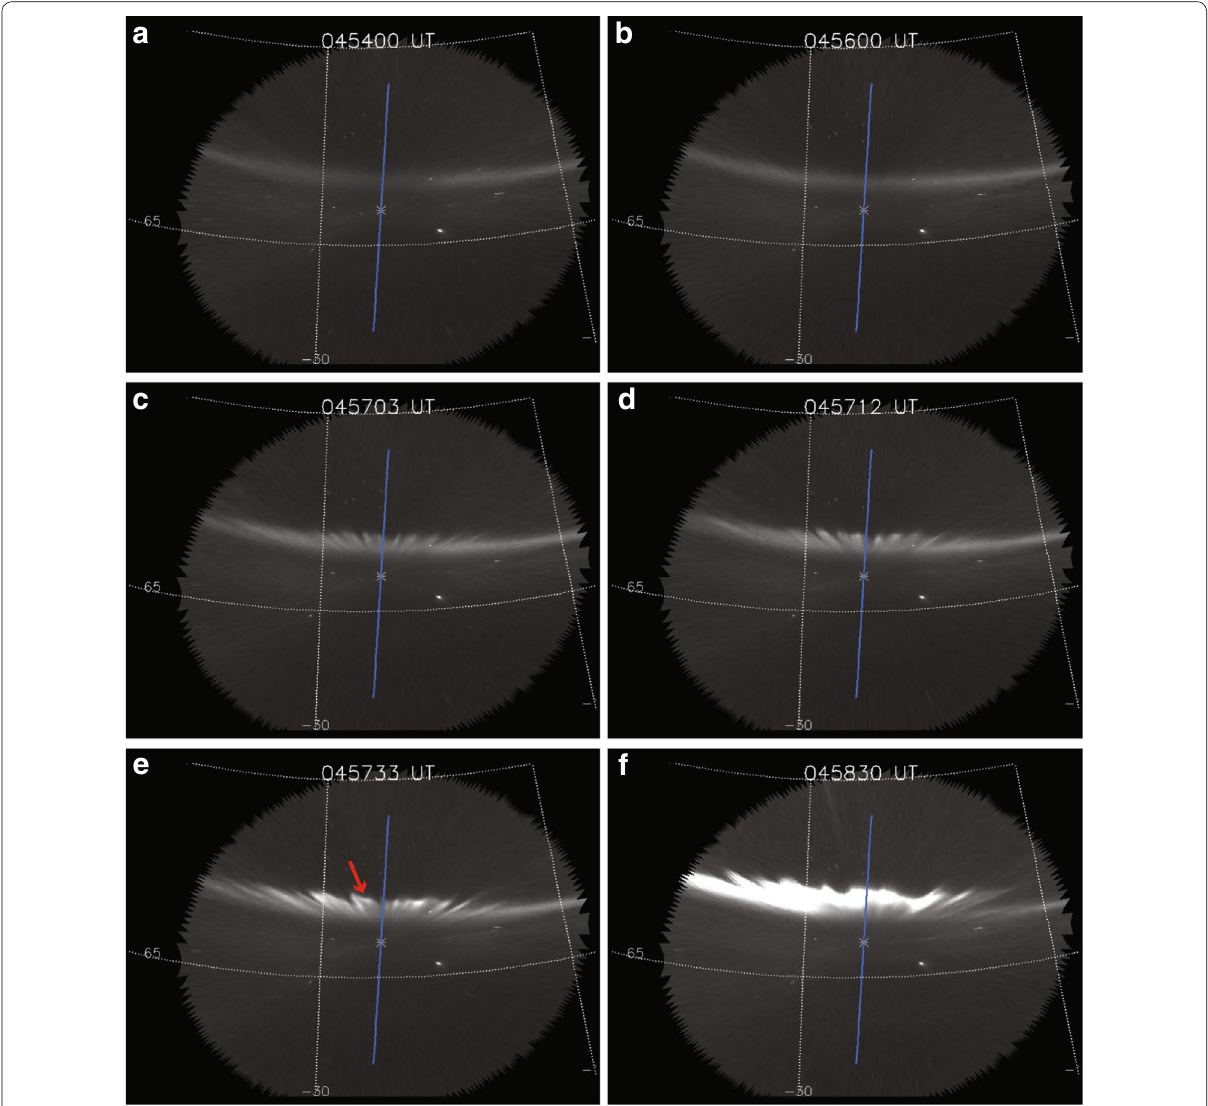
Fig. 1 THEMIS ASI images showing substorm onset on 2011-10-02. A few selected THEMIS ASI images showing the substorm onset on 2011-10-02. The images are mapped in AACGM coordinate by assuming an emission height of 110 km. A blue line in each figure marks the MSP scan line. A white asterisk marks the zenith of the ASI. The images are indexed to facilitate referene in the